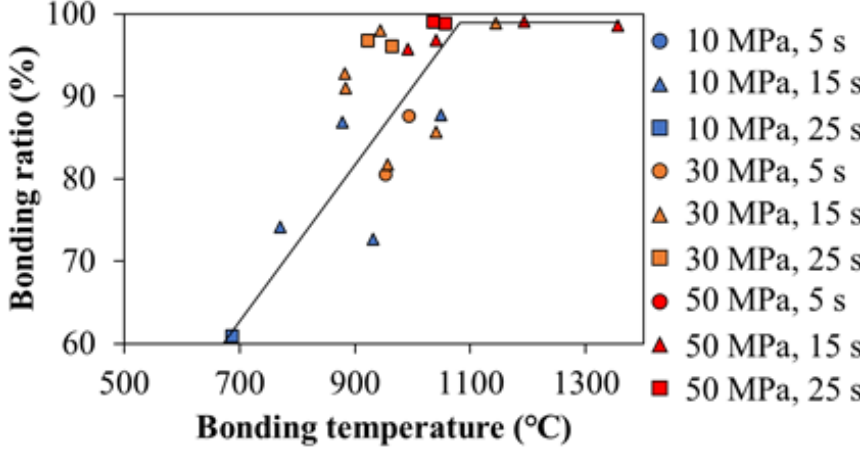
Figure 6. E ff ect of the bonding temperature on the bonding Figure 6. Effect of the bonding temperature on the bonding ratio.